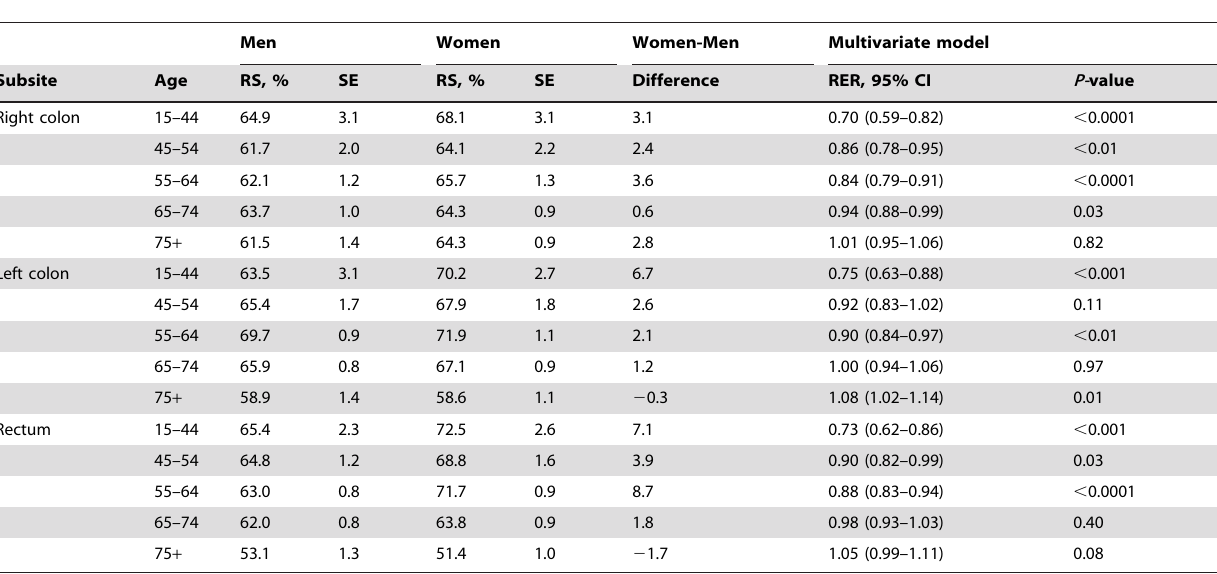
Table 5. Sex differences in 5-year relative survival of colorectal patients for subgroups by subsite and